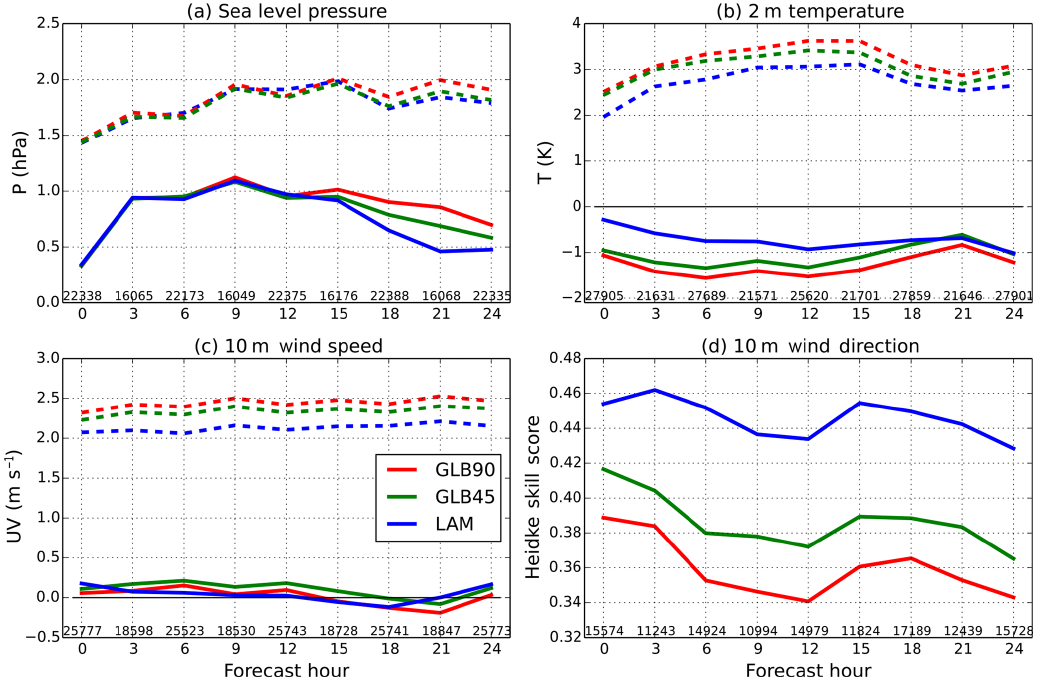
Figure 6. Same as Fig. 5, but for December